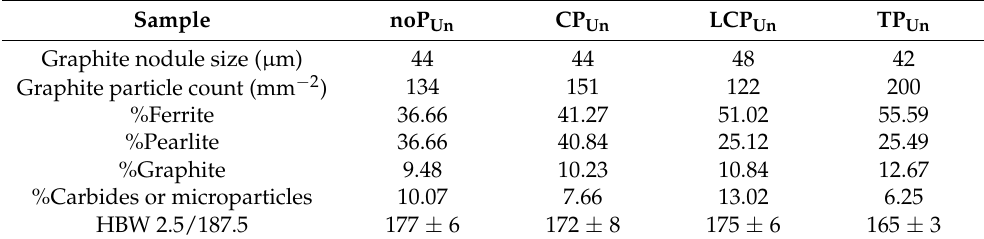
Figure 4. Distribution of nodules’ diameters of ( a ) noP Un , ( b ) CP Un , ( c ) LCP Un , and ( d ) TP Un samples; ( e ) Log-normal distribution of nodules diameters for each treatment. Table 4. Results of image analysis quantification and Brinell hardness results.